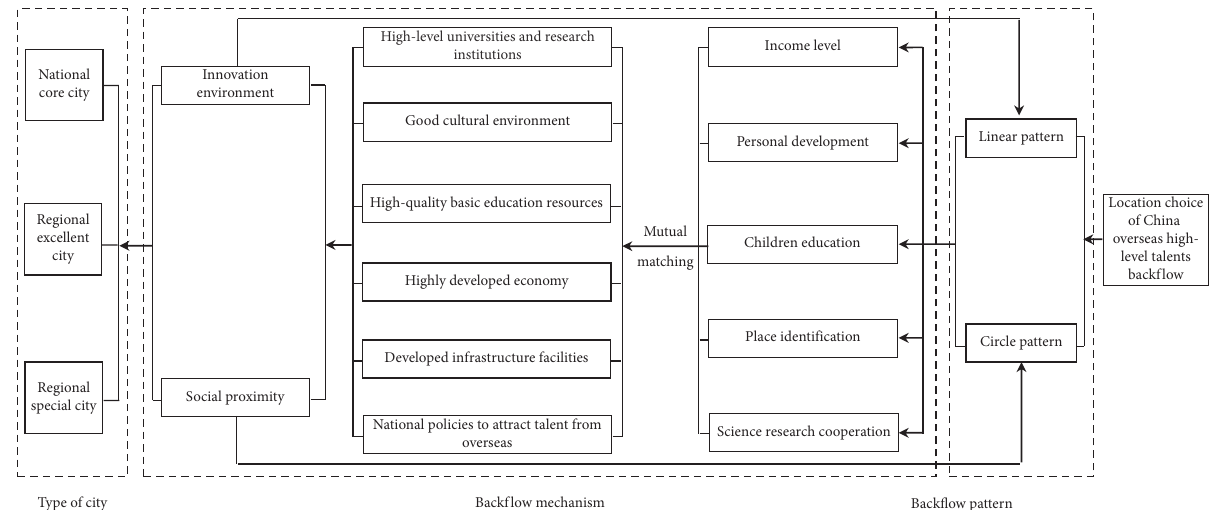
Figure 4: Backflow mechanism and location choice of high-level returned